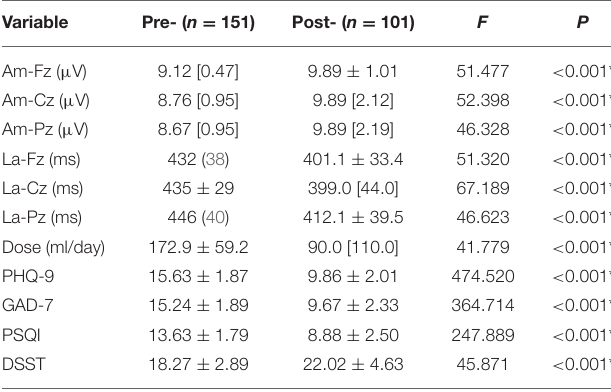
TABLE 6 | The result of multi-level model analysis.